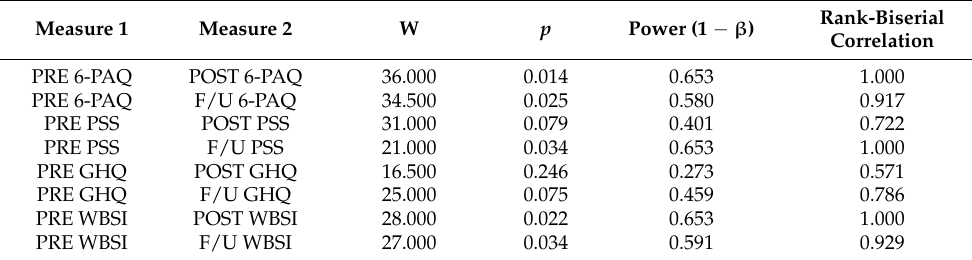
Table 3. Questionnaire scores and comparisons of effect in intervention group.